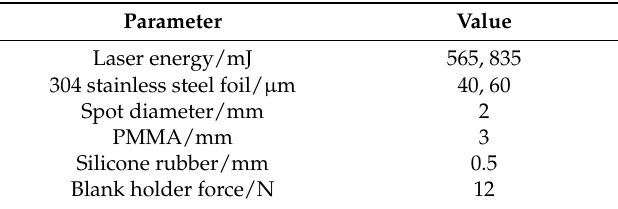
Table 3. The experimental parameters of laser flexible shock micro-bulging.